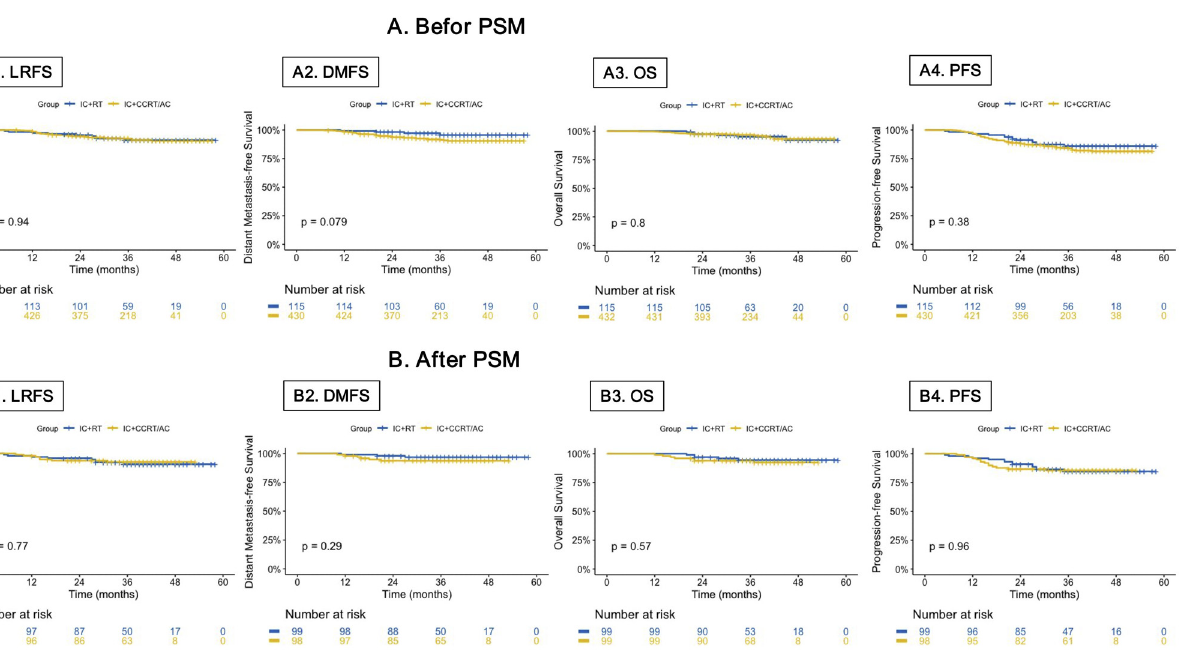
Figure 2. Survival comparisons between IC + RT and IC + CCRT/AC groups before propensity score matching ( A ) and after propensity score matching ( B ), including LRFS (1), DMFS (2), OS (3), and PFS (4). Abbreviations: PSM, propensity score matching; LRFS, locoregional relapse-free survival; DMFS, distant metastasis-free survival; OS, overall survival; PFS, progression-free survival; IC, induction chemotherapy; RT, radiotherapy; CCRT, concurrent chemoradiotherapy; AC, adjuvant